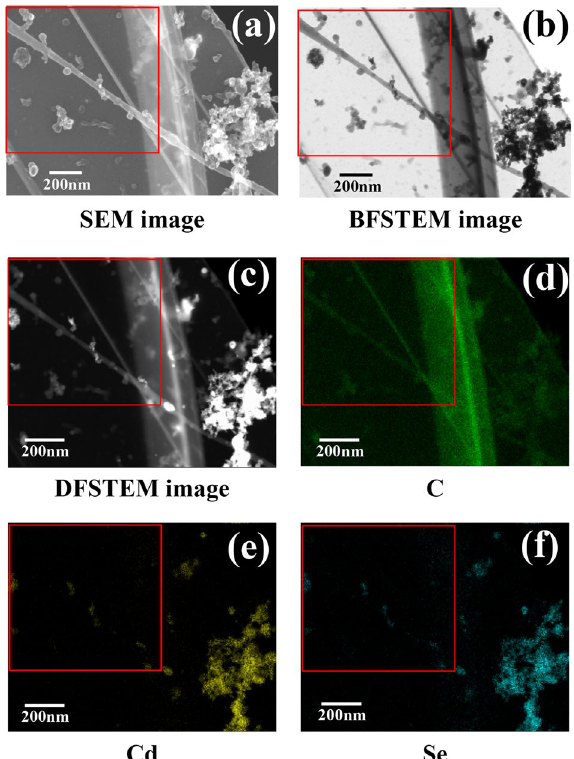
Figure 2. ( a ) High-resolution scanning electron microscopy (SEM), ( b ) bright-field scanning transmission electron microscopy (BFSTEM), ( c ) dark-field scanning transmission electron microscopy (DFSTEM), and energy-dispersive X-ray spectroscopy (EDX) maps of ( d ) carbon, ( e ) Cd and ( f ) Se for the